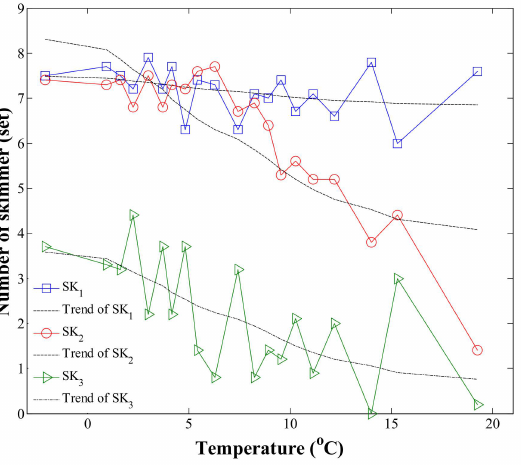
Figure 14. Changes of skimmer combination regarding the uncertainty of wind speed.